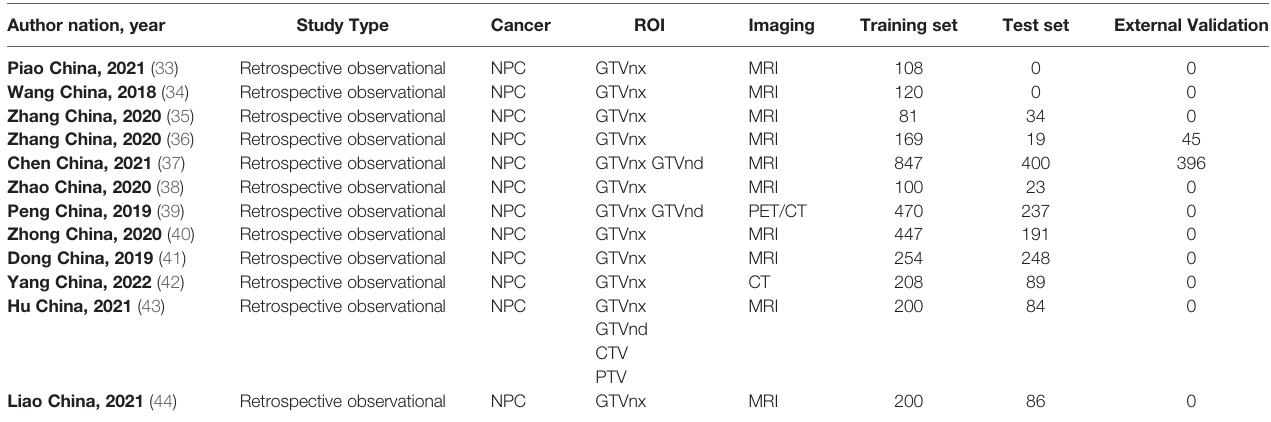
TABLE 1 | Details of eligible studies.